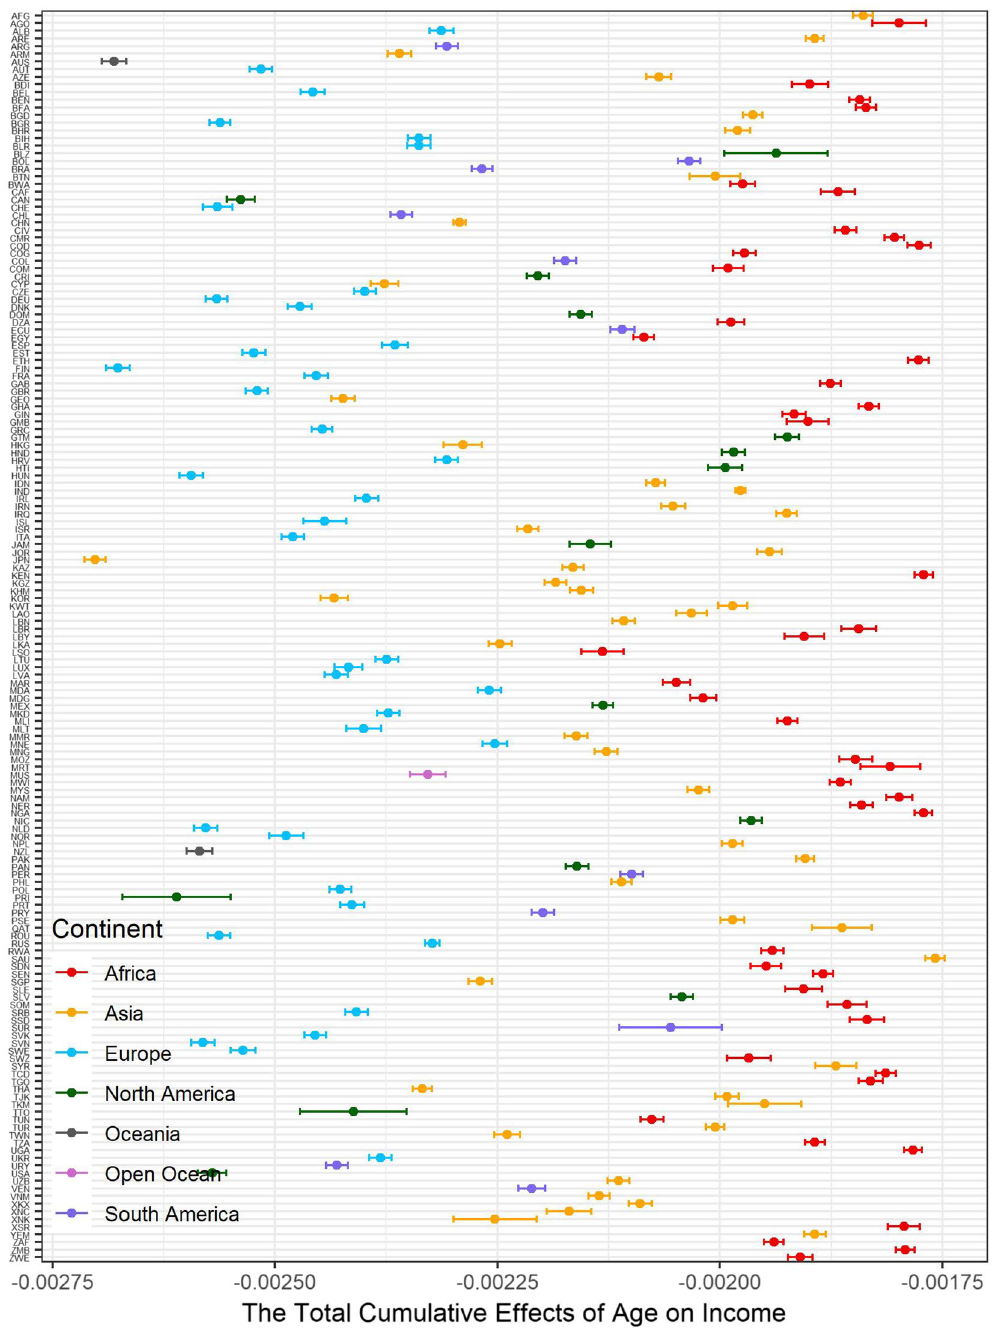
Figure 11. The summary of total cumulative effects of age on income by